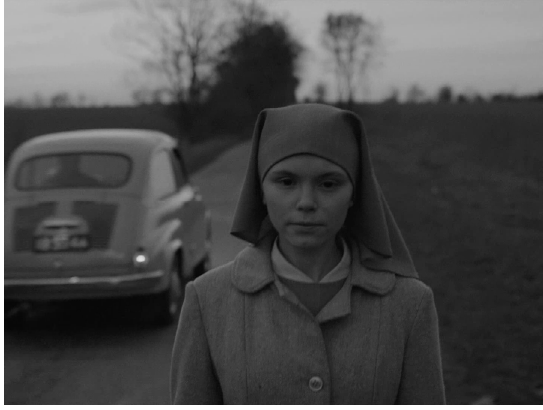
Figure 16. The camera tracks Ida’s movement.